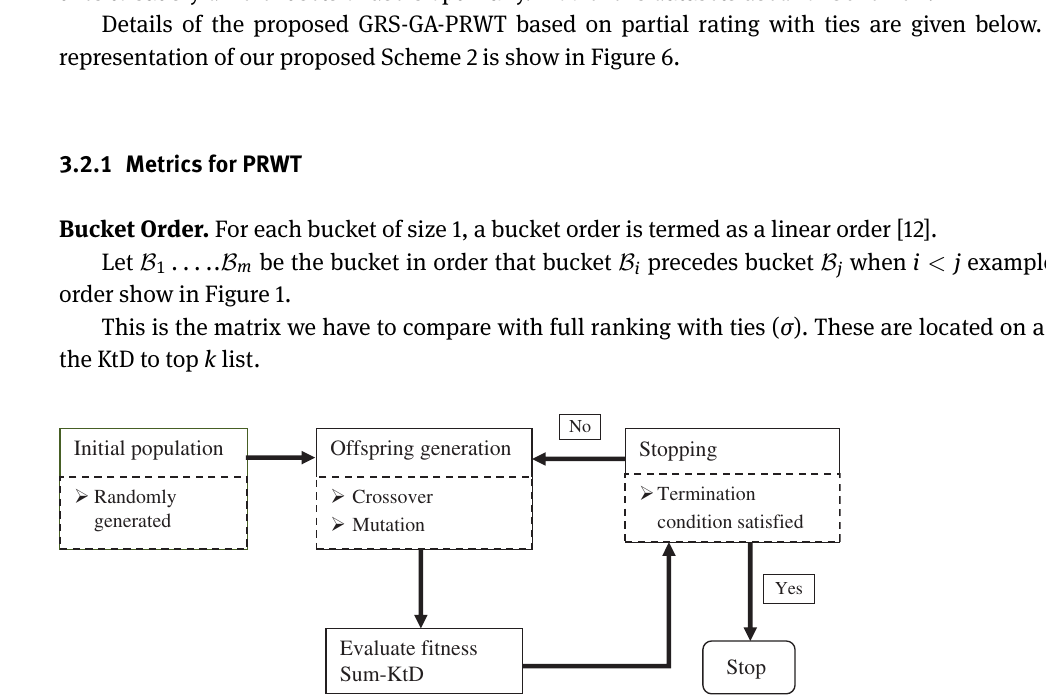
Figure 6: The Schematic Representation of Our Proposed